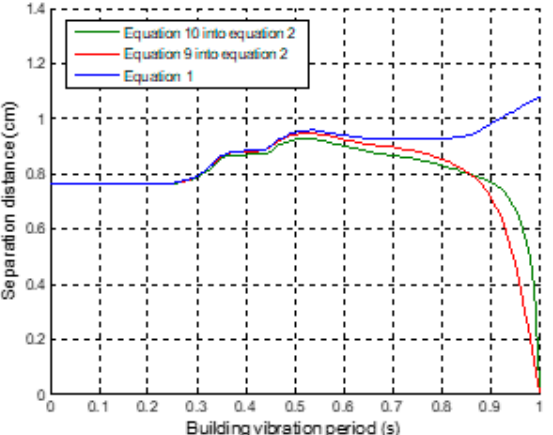
Figure 6. Comparison of the separation distance between two adjacent buildings by using three equations for T j = 1 s and different values of T i.